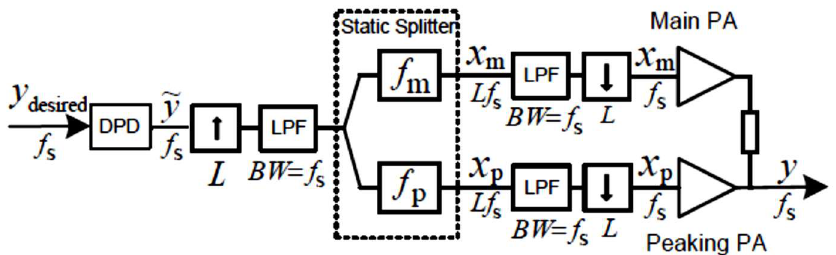
Figure 10. Linearization scheme in dual-input Doherty PA. f s is the initial sampling rate, L denotes the up sampling factor, χ m , χ p are input signals of carrier and peaking PAs [74] .